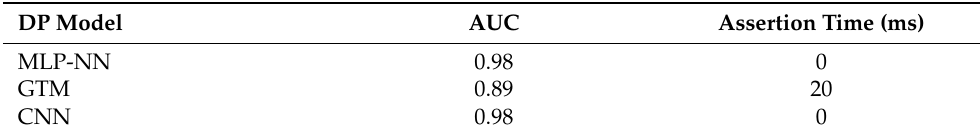
Figure 10. Receiver operating curve (ROC) of the MLP-NN (blue line), the GTM (red line), and the CNN (green line) models. Table 9. AUC and assertion time for MLP-NN, GTM, and CNN models.